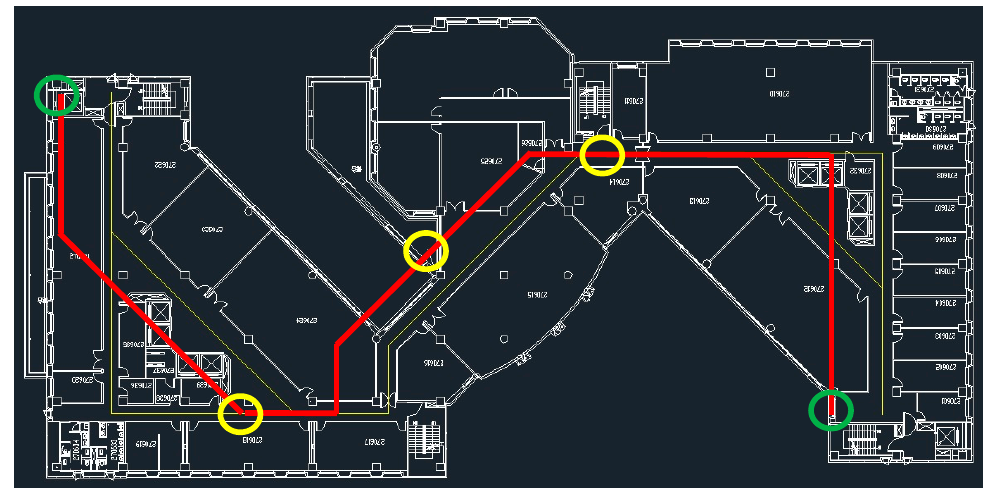
Figure 11. Route map of the experimental area.